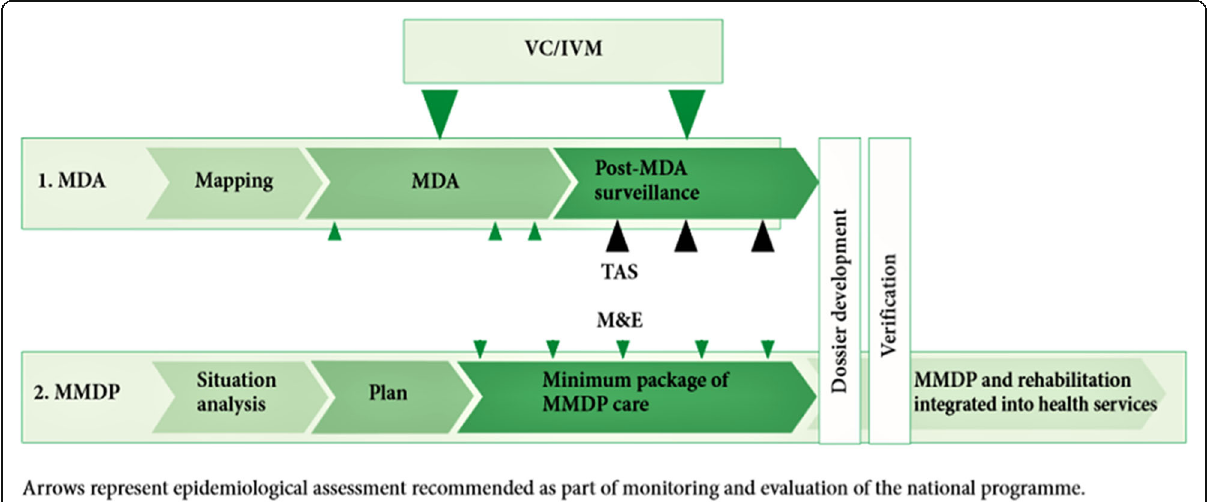
Fig. 2 The Global Programme to Eliminate Lymphatic Filariasis (GPELF) Strategy. Arrows represent epidemiological assessment recommended as part of monitoring and evaluation of the national program. VC/IVM, vector control and integrated vector management; MDA, mass drug administration; TAS, transmission assessment survey; M&E, monitoring and evaluation; MMDP, morbidity management and disability prevention. Source